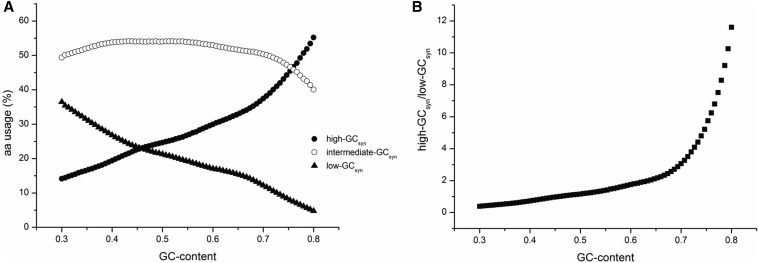
The total usage patterns of three amino acids types. (A) The usage frequencies of high-, low-, and intermediate-GCsyn amino acids change when GC-content increase from 0.30 to 0.80. (B) The amino acid usage ratios of the high-GCsyn to low-GCsyn types are shown.